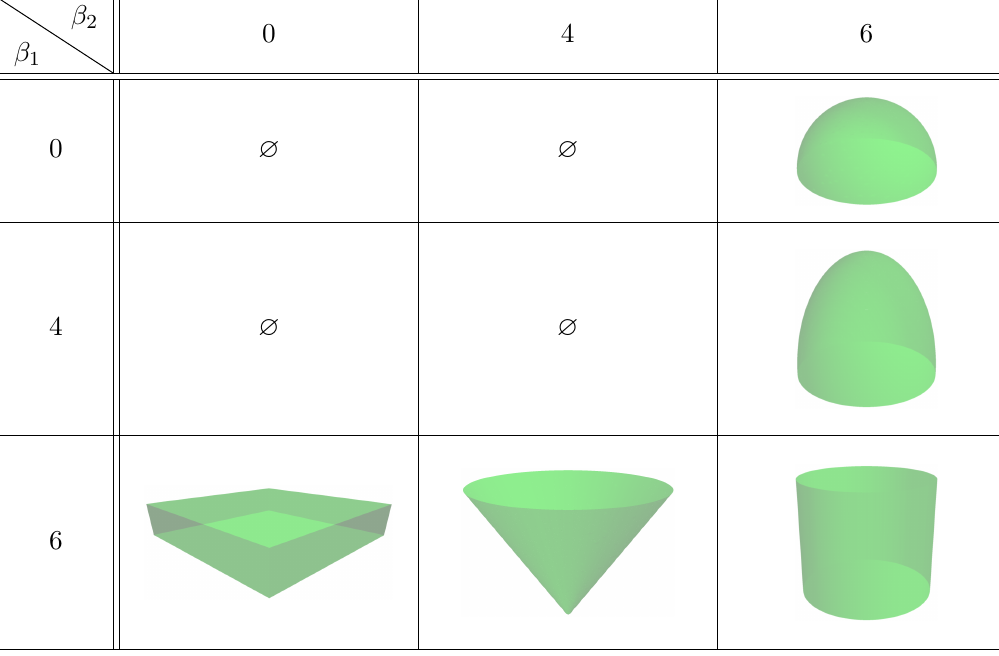
Table 1 . Different types of universal two-flux compactifications and their corresponding acceleration regions in the phase space. The values of β — corresponding to the two species of flux that 1 , 2 are turned on in the solution — depend on the type of flux and its number of legs along the external-space, internal-space and time directions, cf. (5.10). The absence of an acceleration region is denoted by the empty set ?